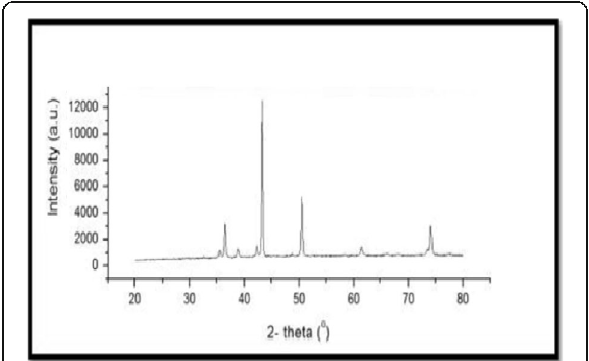
Fig 4 XRD patterns of CuO